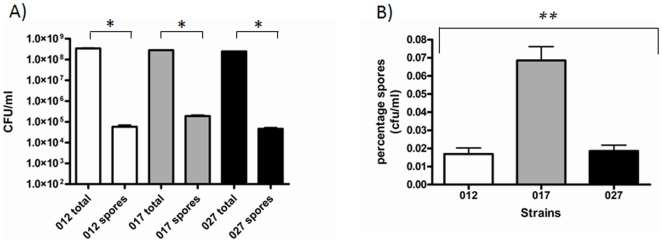
Vegetative cells and Spore counts of C. difficile PCR ribotypes 012, 017 and 027.A) Total cell counts and spore counts were obtained by plating cultures and heat resistant samples of C. difficile on blood plates containing 0.1% taurocholate. B) Percentage spore counts were obtained by calculating the number of heat resistant spores as a proportion of the total cell counts. Data consists of three biological and two technical replicates from separate cultures. Student T-tests were performed between total counts and spores for each strain and significant differences are marked with a bracket * (p<0.05). A comparison for percentage survival of spores was performed using linear regression and a partial F-test, where M68 was the reference strain, a significant difference (p<0.01) in spore production between the three strains is marked with a bracket **.